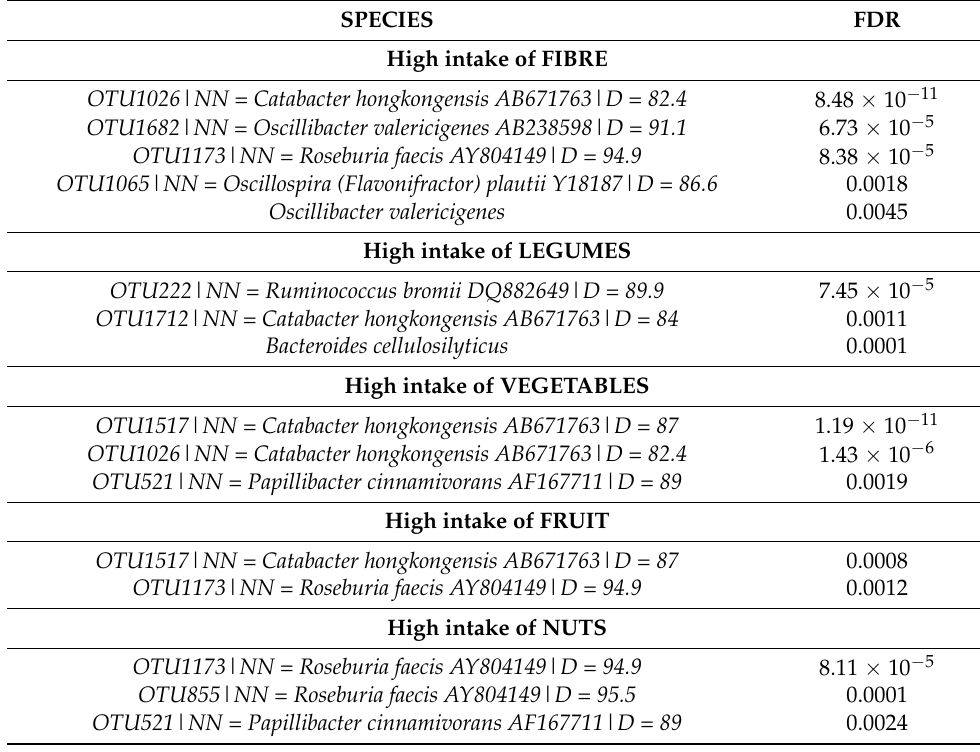
Table 3. Bacterial species and OTUs (Operational Taxonomic Units) significantly related (FDR < 0.05) with the main food groups of the MD, by comparing high and low tertiles of the intake of each food group by metagenomeSeq analysis.